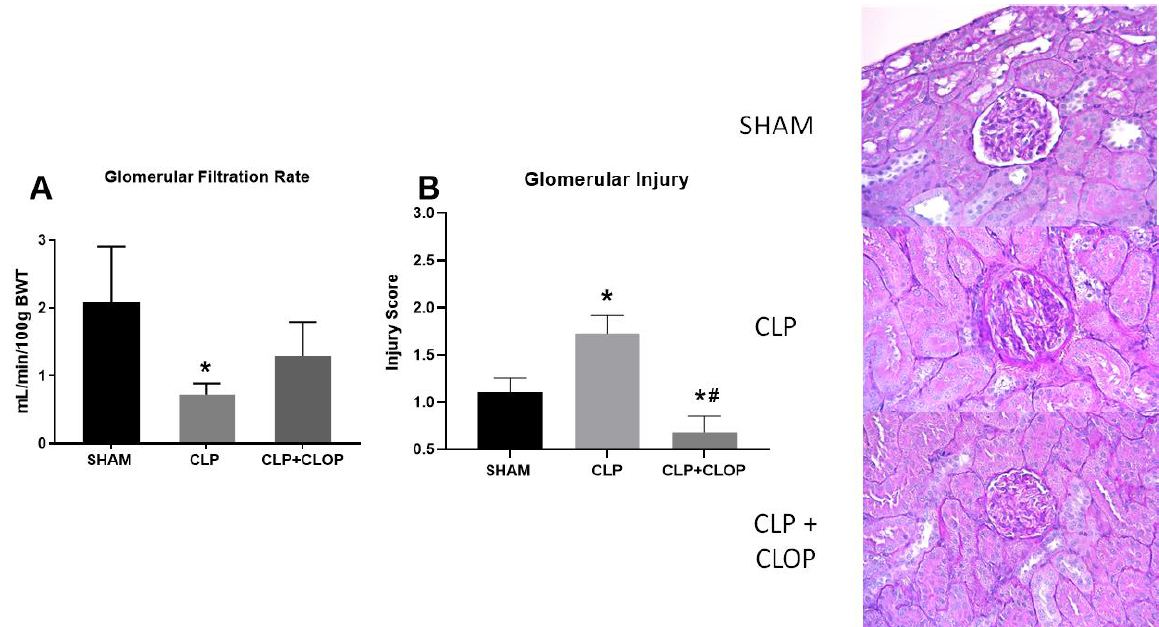
Figure 6. Renal function and injury. Glomerular filtration rate was assessed via FITC sinistrin clearance in Sham, CLP, and CLP + CLOP rats ( A ; n = 6 ). Periodic acid Schiff (PAS) staining was performed on paraffin-embedded kidneys from Sham, CLP, and CLP + CLOP rats (representative images). Glomerular injury ( B ; n = 6/group) was scored from PAS-stained sections. * p < 0.05 vs. Sham, # p < 0.05 vs. CLP.